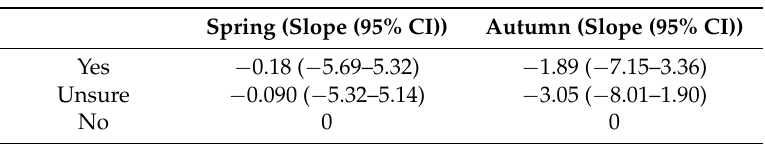
Table 5. Vitamin D concentrations among children (2–15 years) in relation to sun exposure guidelines in the Day care/kindergarten/after school club a